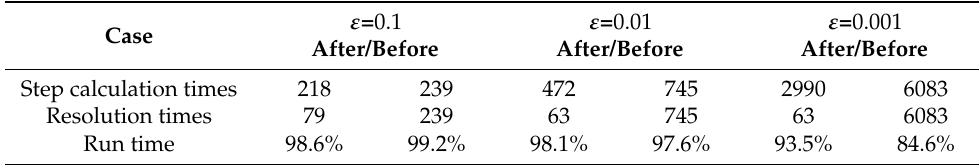
Table 3. Comparison of the C06 satellite visibility solving efficiencies.